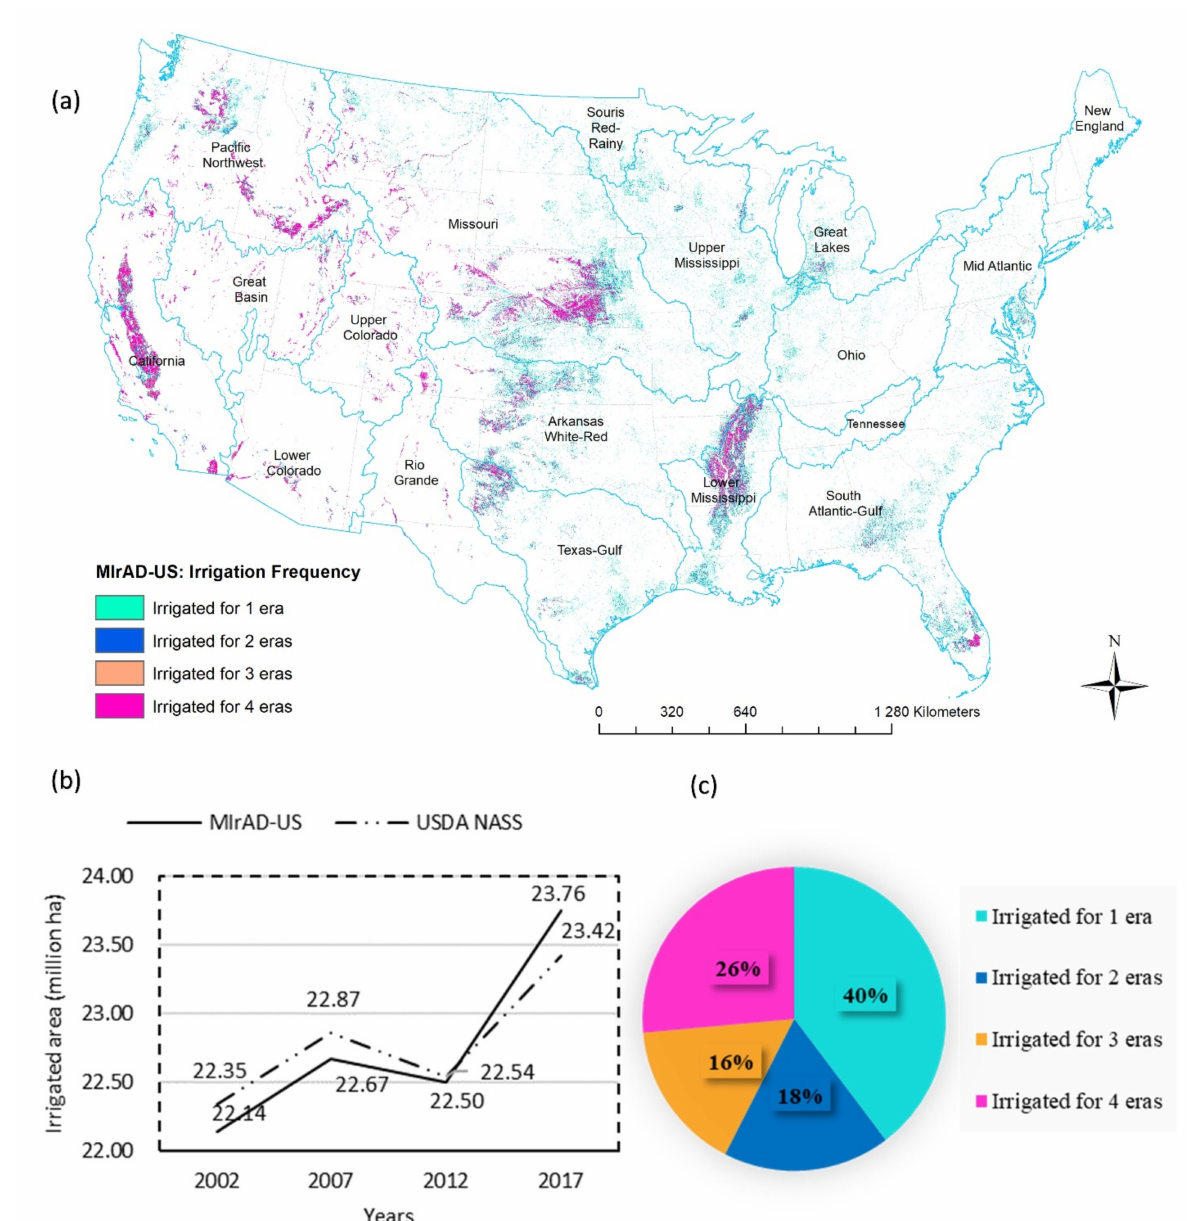
Figure 1. MIrAD-US estimations of irrigated land across CONUS: ( a ) map showing the CONUS-wide distribution of irrigation frequency for four eras where blue polygons represent CONUS-wide HUC2 watershed boundaries and light blue, dark blue, light orange, and pink represent irrigated area for 1, 2, 3, and 4 eras, respectively ( b ) total irrigated area (in million ha) estimated by MIrAD-US and USDA NASS for four eras, and ( c ) pie chart showing percentage of frequency of irrigated land for four